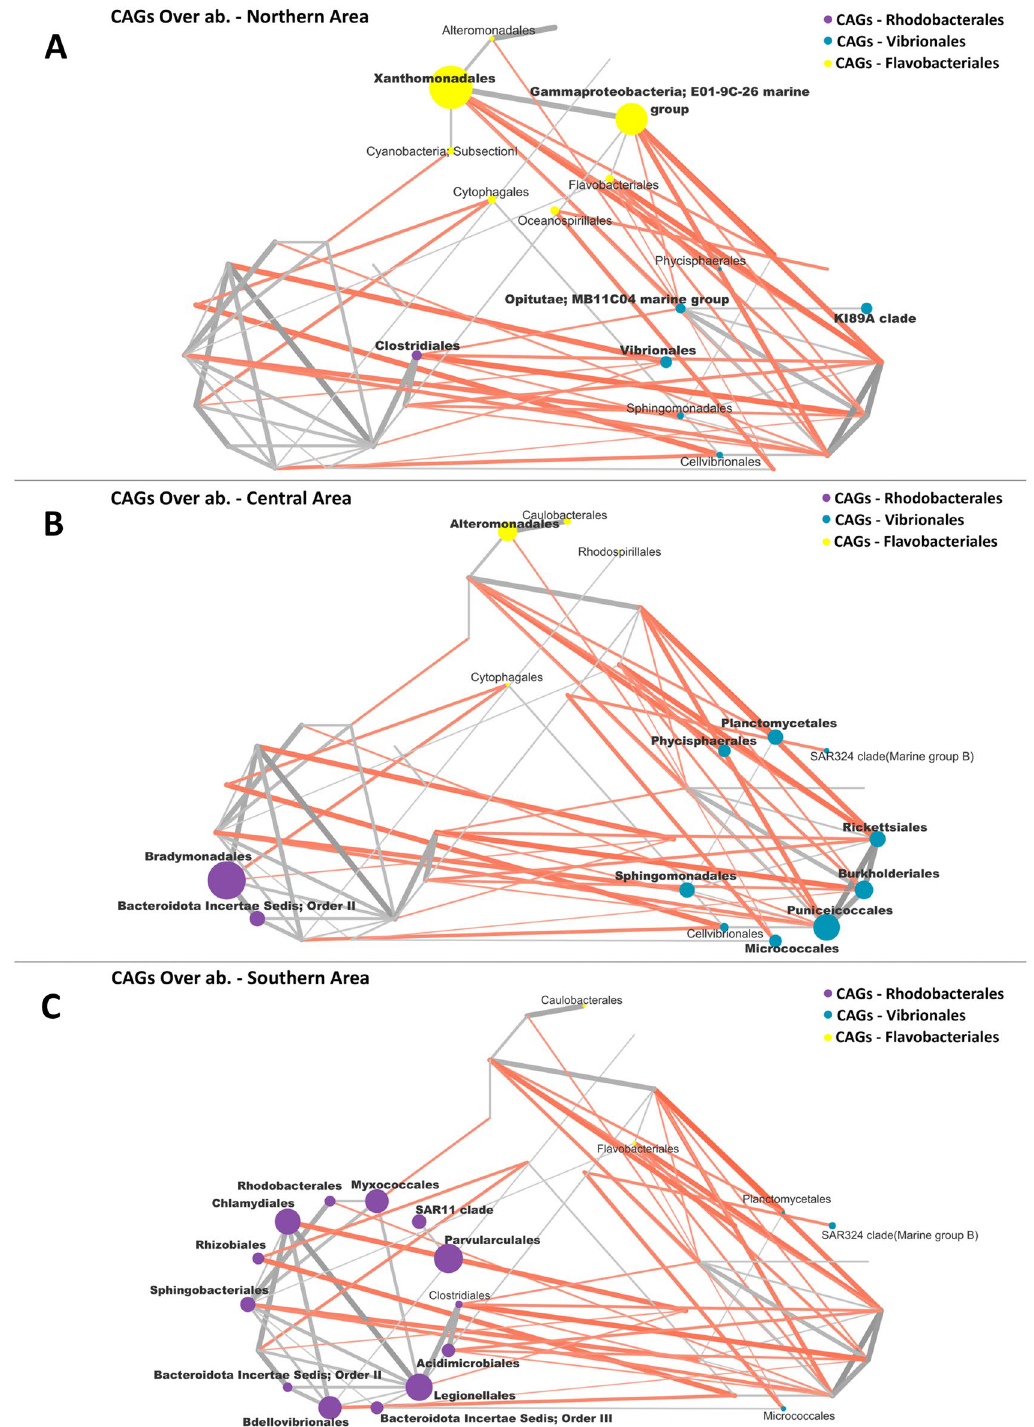
Figure 7. Wiggum plots representing the over-abundance of each bacterial order in the 3 CAGs in the water ecosystem in each Area: ( A ) Northern Area; ( B ) Central Area and ( C ) Southern Area. CAGs are named according to the most abundant order in each CAG and are colour coded as follows: Rhodobacterales (Violet), Vibrionales (Bondi Blue) and Flavobacteriales (Yellow). Each bacterial order is depicted as a node whose size is proportional to its over-abundance. Node and name of bacterial order with an over-abundance < 1 are not represented, and those with an over-abundance ≥ 1.3 are